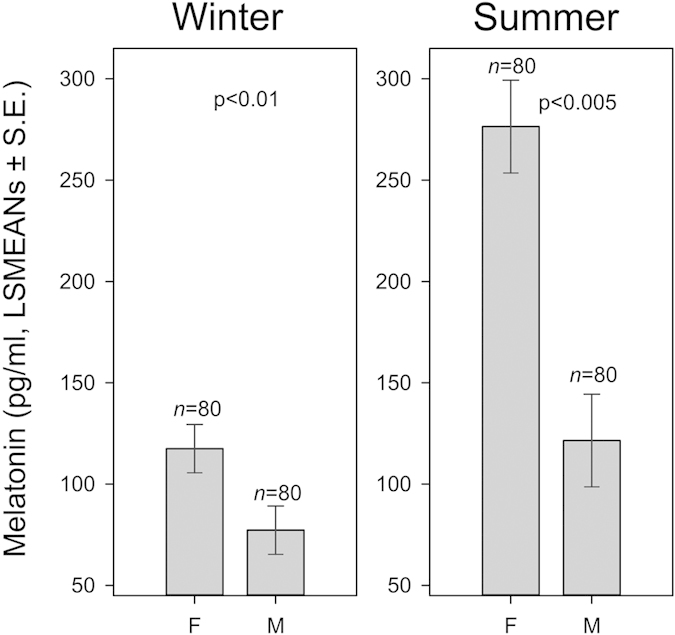
Melatonin concentrations (pg/ml) for female (F) and male (M) calves (LSMEANs ± S. E.), values from control and experimental animals combined, in winter (left) and summer (right).